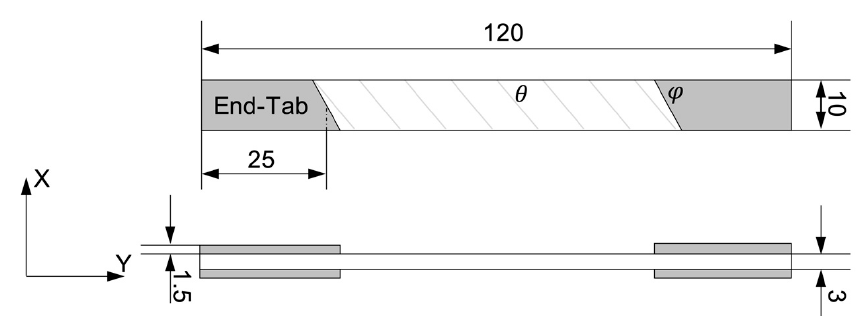
Figure 2. Off-axis tension specimen with oblique